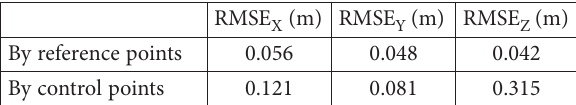
Table 3. Ferotriangulation network accuracy assessment